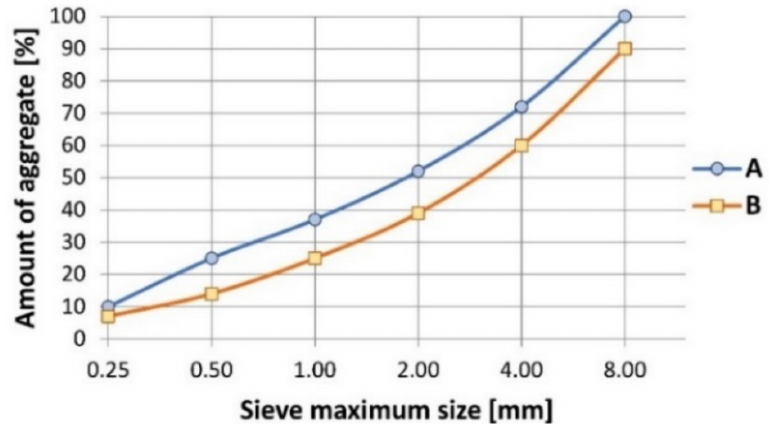
Table 2. The parameters of recycled steel fibers.